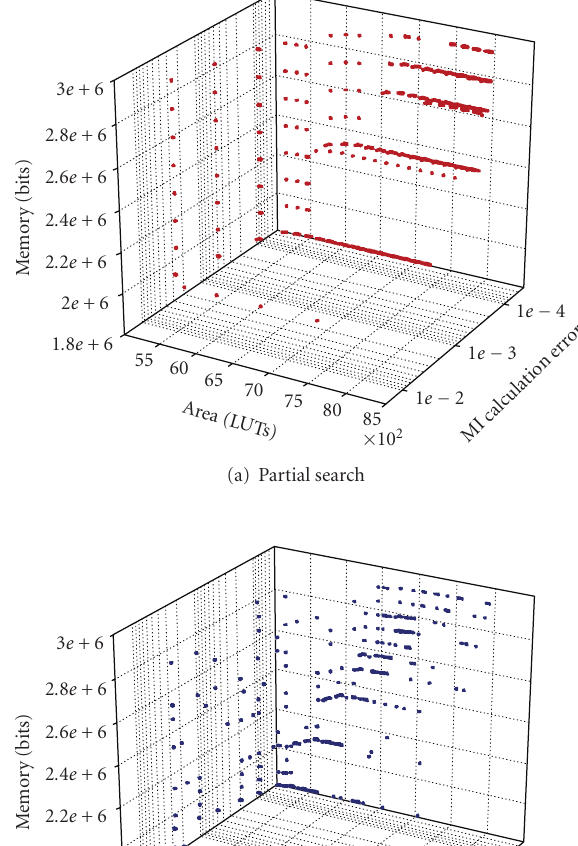
Table 2: Number of solutions explored by search methods.